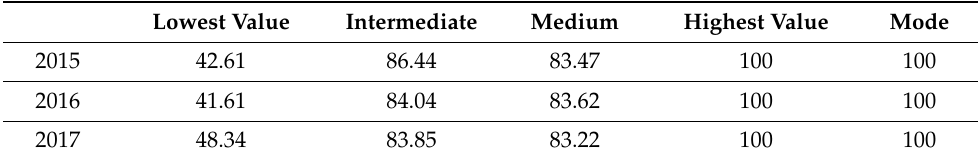
Table 3. The distribution of students admitted to college after the preparatory year.